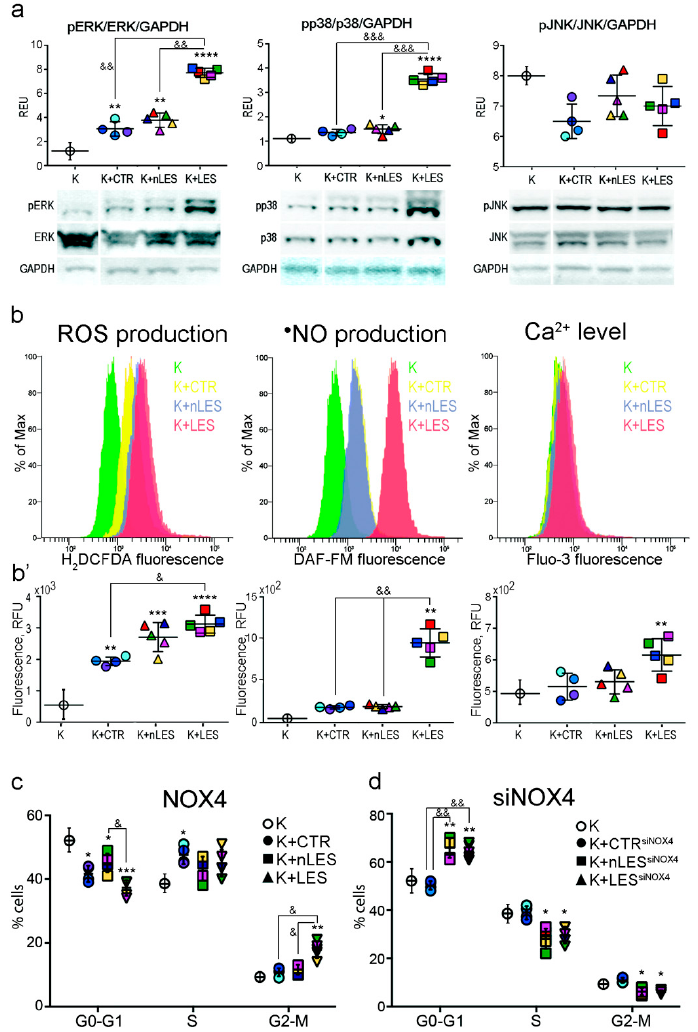
Figure 5. Co-culture with fibroblasts alters MAPK signalling, redox homeostasis and cell cycle in primary human keratinocytes (K). ( a ) Western blot analysis revealed ERK1/2 and p38 pathways activation in K co-cultured with control fibroblasts (K+CTR) and psoriatic non-lesional (K+nLES) and lesional (K+LES) fibroblasts, respectively, with respect to K not in co-culture. Co-culture with fibroblasts didn’t bring to any significant alteration in the JNK pathway in K in our experimental conditions. ( b ) Following the co-culture with fibroblasts, K were stained with H 2 DCFDA, DAF-FM and MitoSOX markers in order to estimate the total intracellular ROS, •NO and Ca 2+ levels, respectively, by flow cytometry. ( b’ ) The quantification of emitted fluorescence assayed by flow cytometer showed that co-culture with fibroblasts significantly increased intracellular ROS production in K. Only co-culture with LES dramatically increased the intracellular •NO and Ca 2+ content vs. K. ( c ) Co-incubation with fibroblasts and, especially, with LES, altered the distribution of K in G0-G1, S and G2-M phases of cell cycle measured by FACS Analysis. ( d ) Transfection of fibroblasts with siNOX4 RNAs induced the accumulation of K in G0-G1 phase of the cell cycle. In dot plot graphs, each patient / control is identified by a di ff erent color (see Table 3). Values are presented as means ± SD. Each experiment was performed in triplicate. & p < 0.05, && p < 0.01, &&& p < 0.001; * p < 0.05 vs. K, ** p < 0.01 vs. K, *** p < 0.001 vs. K, **** p < 0.0001 vs.